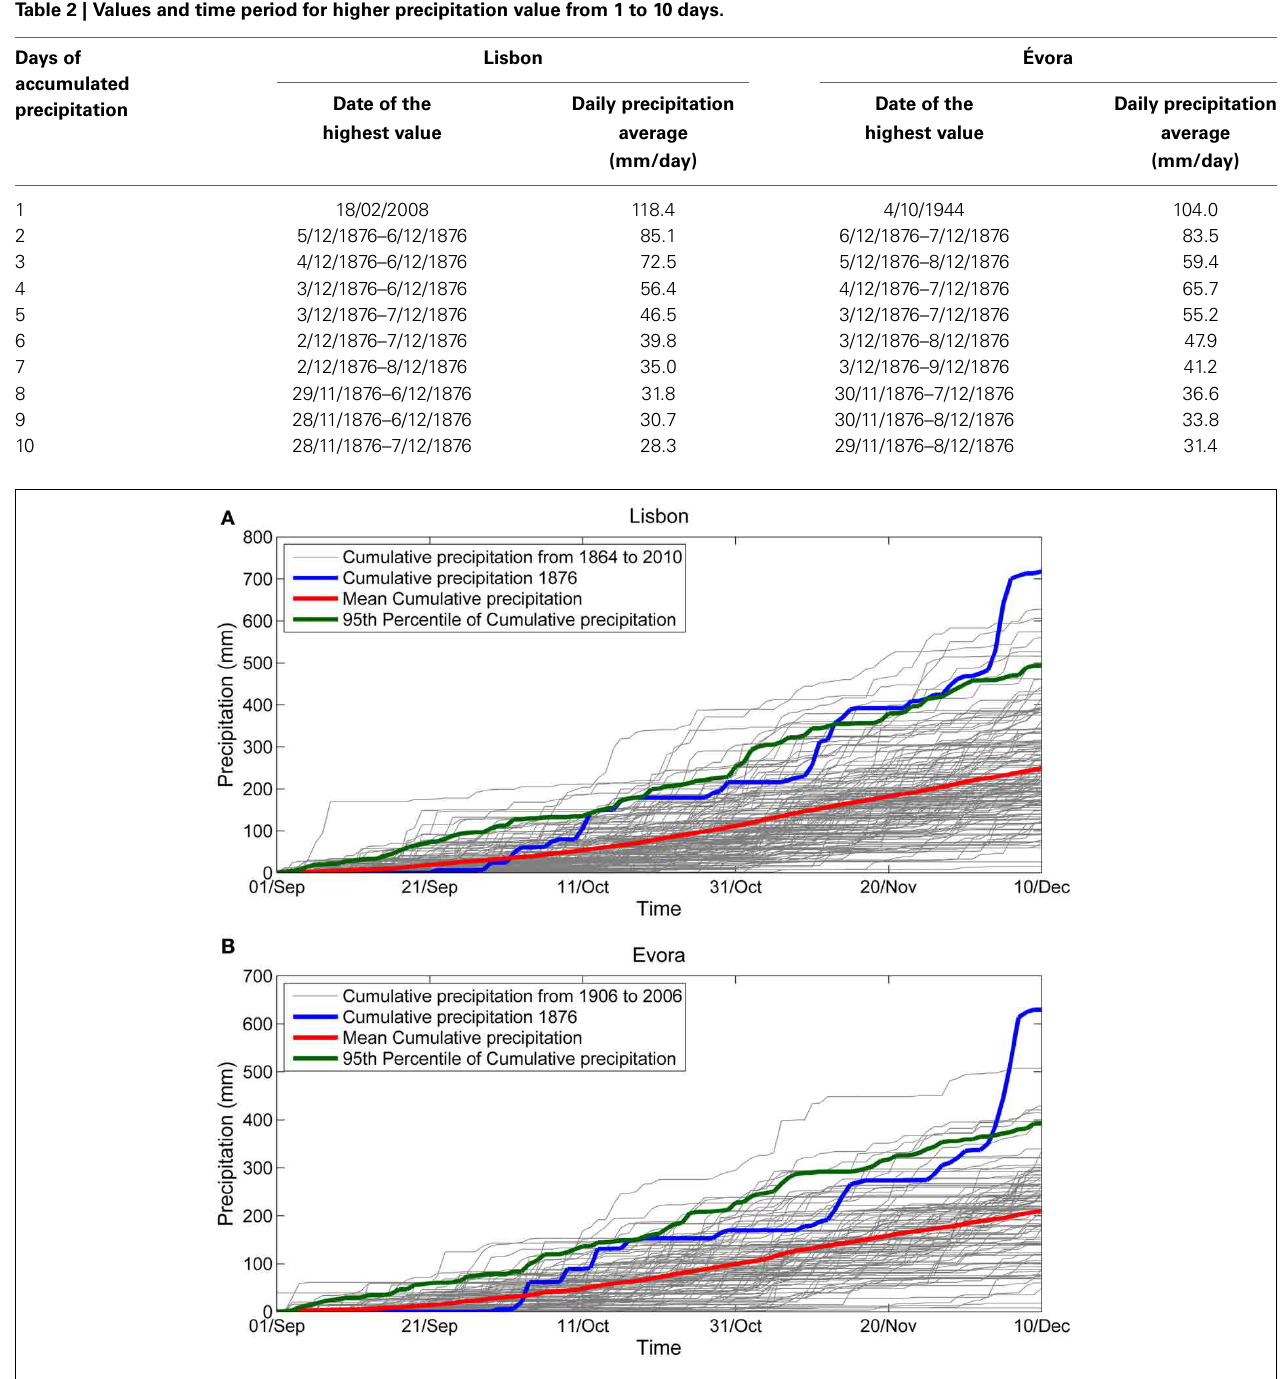
FIGURE 6 | Cumulative precipitation from the 1st of Setember to the 10th of December using sation data. Each year of cumulative precipitation for (A) Lisbon (1864–2010) and (B) Evora (1906–2006) is represented in gray.